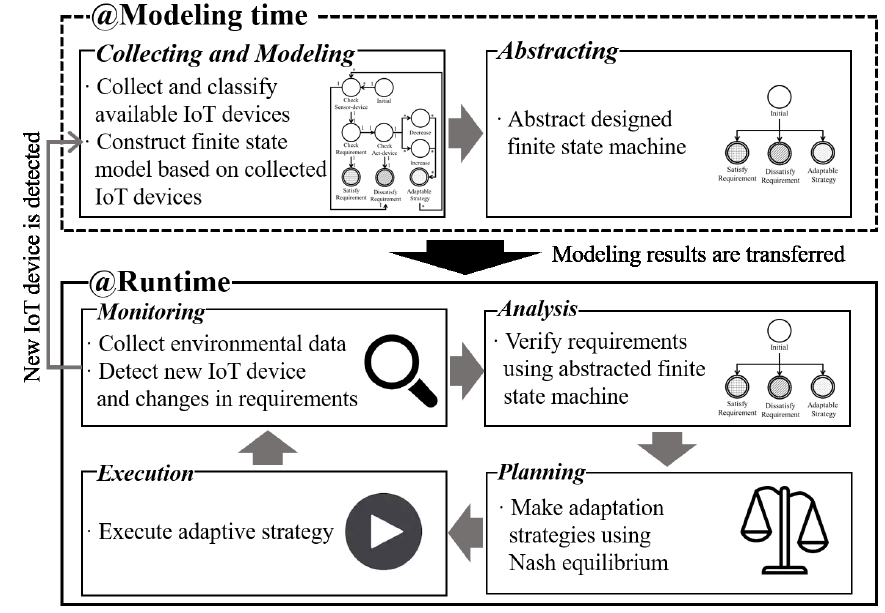
Figure 1. Overview of proposed